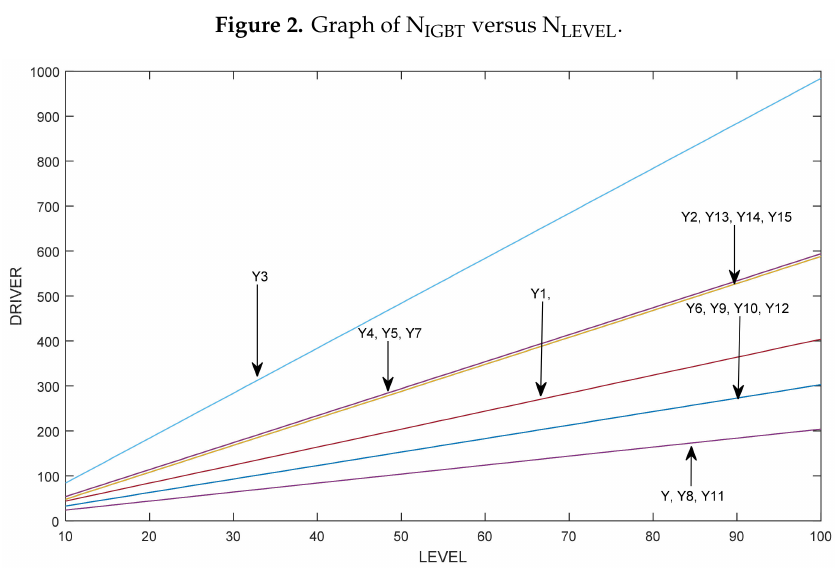
Figure 3. Graph of N DRIVER versus N LEVEL .